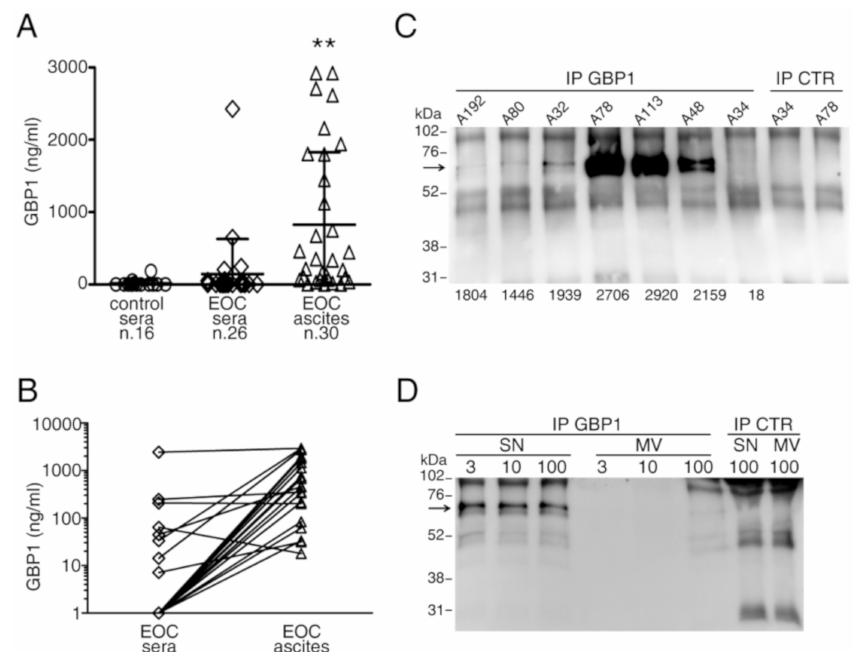
Figure 5. The full-length GBP1 protein form accumulates in the ascites of EOC patients. ( A ) GBP1 levels, detected by ELISA, are significantly higher in the ascites of EOC than in the sera of EOC patients or healthy donors (** p < 0.002). ( B ) A paired Student’s t-test analysis of sera and ascites from the same patients shows significantly higher GBP1 levels in the ascites ( p < 0.0012). ( C )Western blot analysis of anti-GBP1-immunoprecipitated molecules shows a 67 kDa form in the ascites with high GBP1 but not in a low-GBP1 one. The numbers below each lane represent GBP1-ELISA values (ng / mL) of the samples. The last two lanes show a control IP using sepharose-protein G only. ( D ) A high-GBP1 ELISA ascites (A101) was fractionated by centrifugation at 3000, 10,000 or 100,000 × g . Anti-GBP1 immunoprecipitated molecules from the supernatant fractions or from the corresponding microvesicle fractions were analyzed by Western blot, which showed that the 67 kDa GBP1 is mostly in the supernatant fractions. 2.4. The Full-Length, Soluble Molecular Form of GBP1 Accumulates in the Liquid Phase of EOC